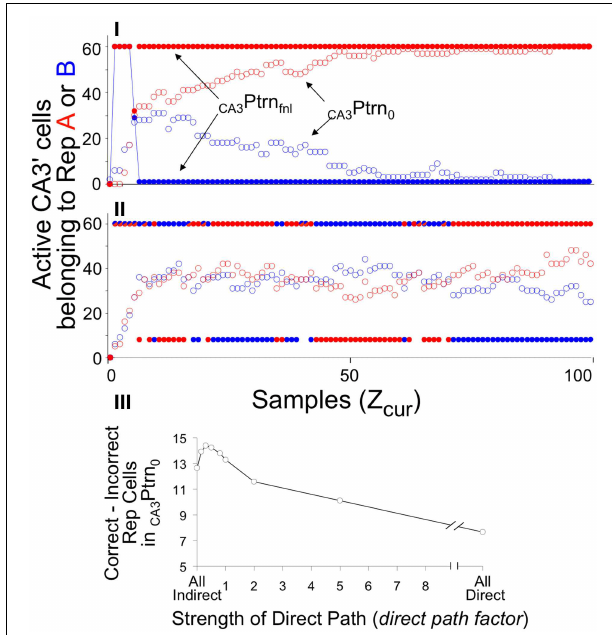
FIGURE 8 | CA3 Ptrn o and CA3 Ptrn Fnl activity during recall of context A when BACON is familiar with both it and another context B. Z rec for A is 95 and for B is 80. (I) Contexts A and B are maximally distinct (50% of attributes in common—only those common to all contexts). (II) Contexts A and B are very similar (95% of attributes in common). In both cases a mix of Representation A and B cells is active in the initial CA3 ′ pattern prior to recurrent input ( CA3 Ptrn o ), whereas whichever representation has the larger number of representatives active initially has all K = 60 of its members active after two cycles of recurrent input ( CA3 Ptrn Fnl ). Note that since there is some overlap between the representations, the final pattern necessarily has some representation A cells active when representation B is being expressed, and conversely. When the contexts are very different (I) , the final pattern is consistently the complete representation of A after sampling only a few attributes, and by the time about half of the full set of attributes have been sampled, the initial pattern is also the complete correct representation. However, when the contexts are very similar (II) , the initial pattern is never either representation in pure form, and only after about two thirds of the total set of attributes has been sampled is the final pattern consistently the complete valid set of representation cells. Note that in (II) there were a number of occasions when the recurrent collateral system caused exactly equal excitation of both representations. Such cases are indicated by half red/half blue CA3 Ptrn Fnl points; there are therefore more than K neurons active in the final CA3 ′ pattern, and under that circumstance, EC’ out activity is suppressed. (III) The difference between the number of A and B representation cells in CA3 Ptrn o as a function of strength of direct path synapses ( dpf = factor multiplying strength of direct path synapses on CA3 ′ cells), with patterns A and B 93% similar. This is an average of 24 sets of simulations. For each set the same random connectivity and the same attribute sampling orders were used for a simulation at each dpf value. Paired t -test for All Indirect vs. All Direct, All Indirect vs. dpf = 0 .15, and dpf = 0 .3 vs. 1.0 were all significant at p < 0 . 01 or